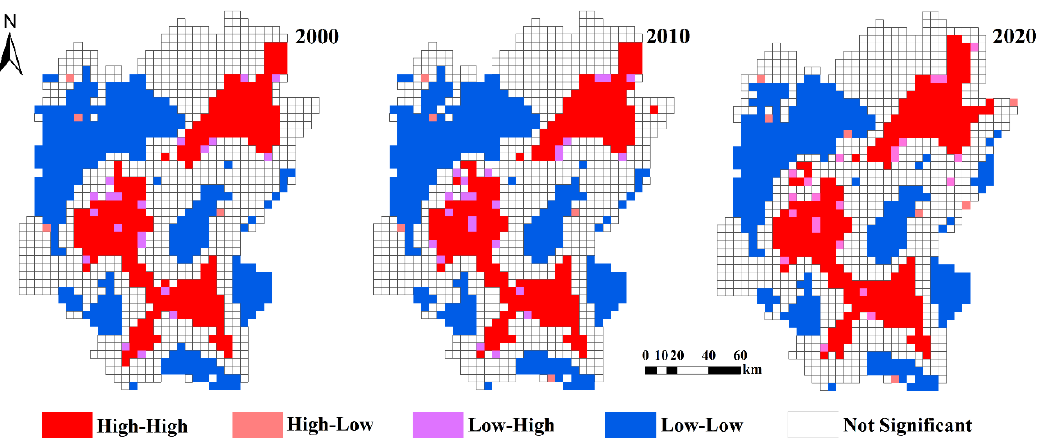
Figure 9. Local autocorrelation diagram of ecological risk. Table 6. Statistics on local autocorrelation types of ecological risks in Guilin from 2000 to 2020.